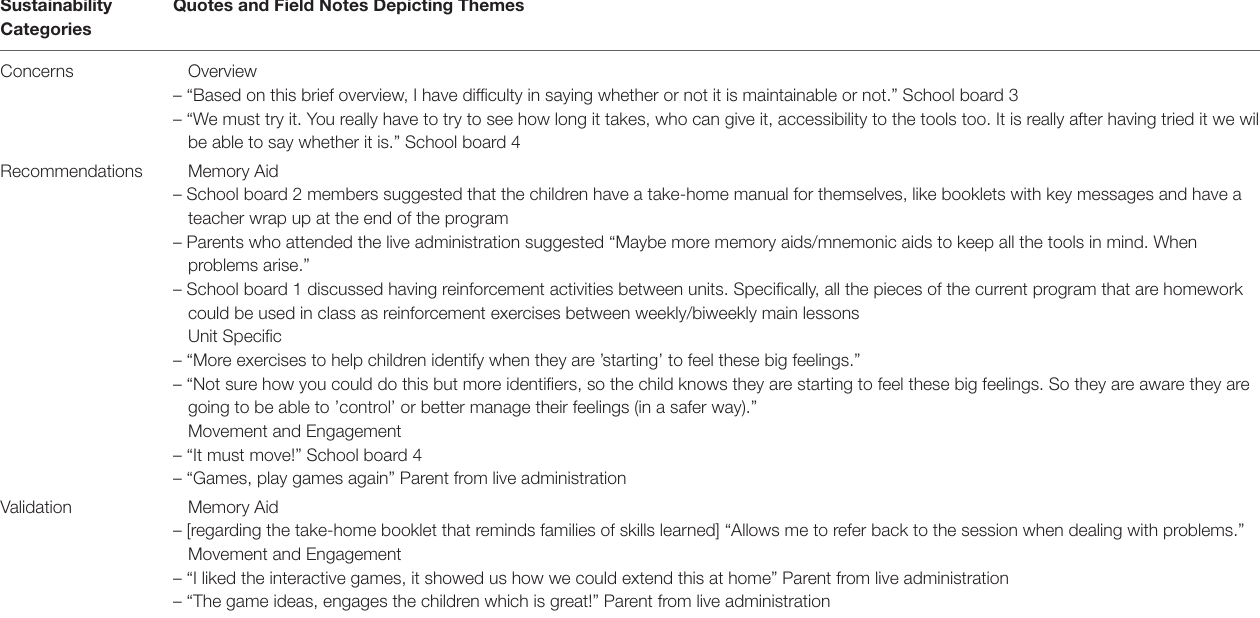
TABLE 5 | Sustainability qualitative